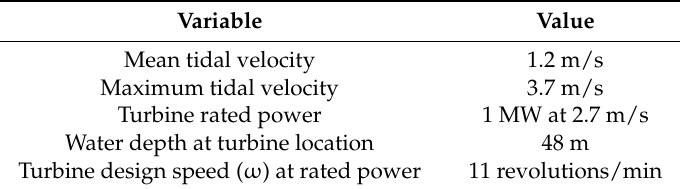
Table 1. Data of Andritz Hydro Hammerfest turbine at the Sound of Islay